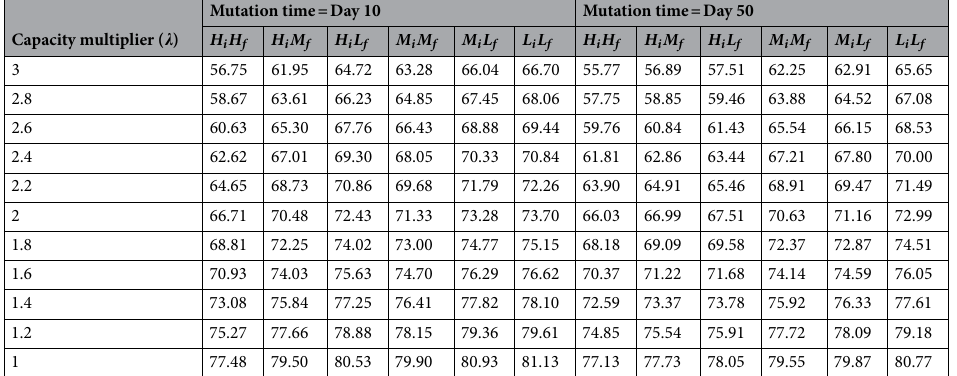
Table 3. Infection attack rate (%) under different capacity multipliers and vaccine types when mutation time is day 10 and day 50.